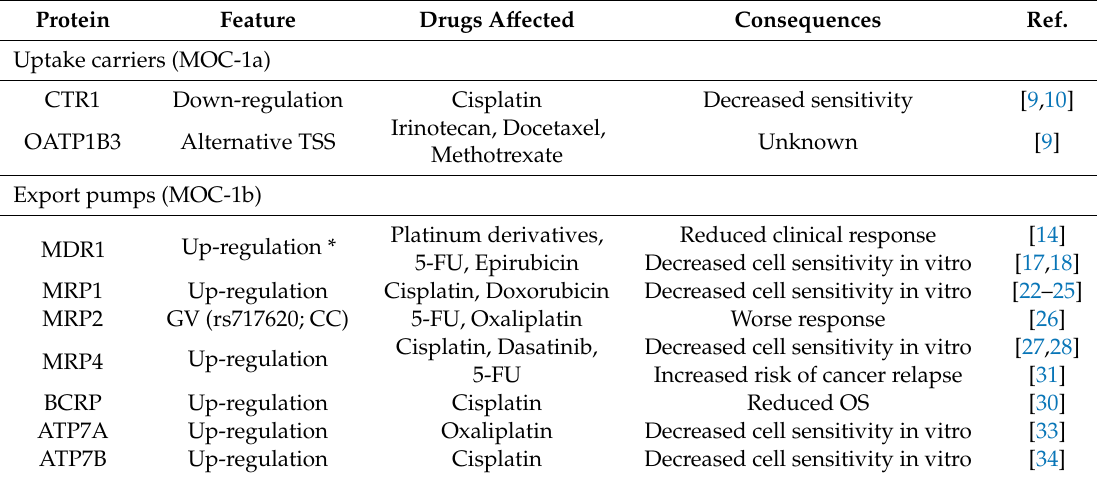
Table 1. Mechanisms of chemoresistance type 1 (MOC-1) to drugs used in the treatment of GAC. Protein Feature Drugs A ff ected Consequences